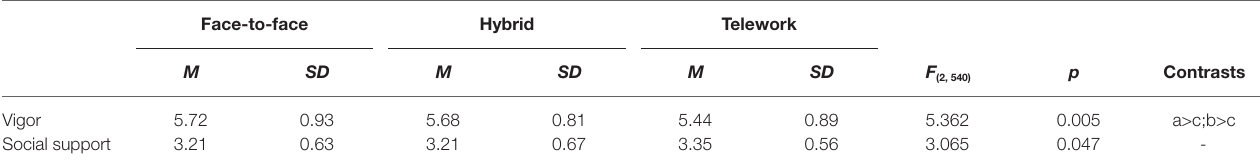
TABLE 2 | Vigor and social support by work modality.